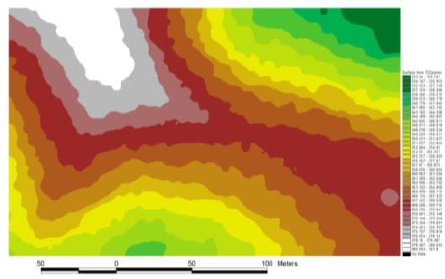
Figure 10. DEM created from reduced LiDAR data down to point cloud density of 0.017pts/m 2 .